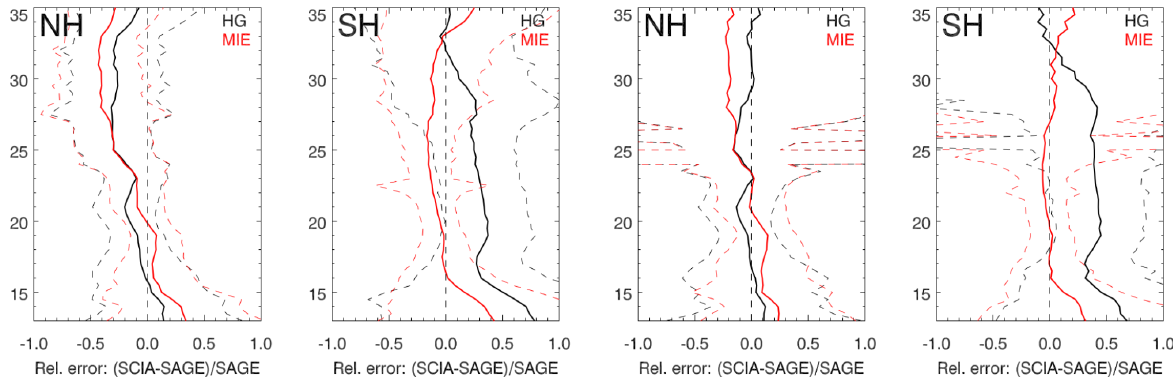
Figure 4. Left panels: comparison between SCIAMACHY version 1.0 (HG) and Version 1.1 (MIE) with SAGE II version 6.2 stratospheric aerosol extinction profiles at 525nm for both hemispheres. Right panels: similar to left panels, but for SAGE II version 7.0.